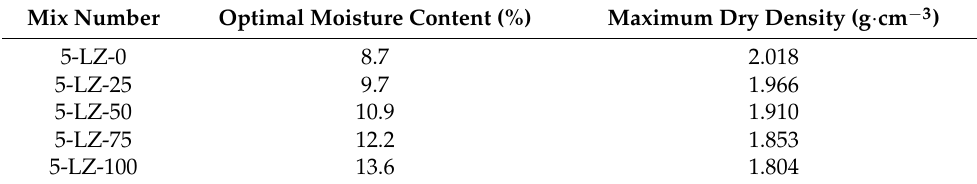
Table 5. Specimen optimal moisture content and maximum dry